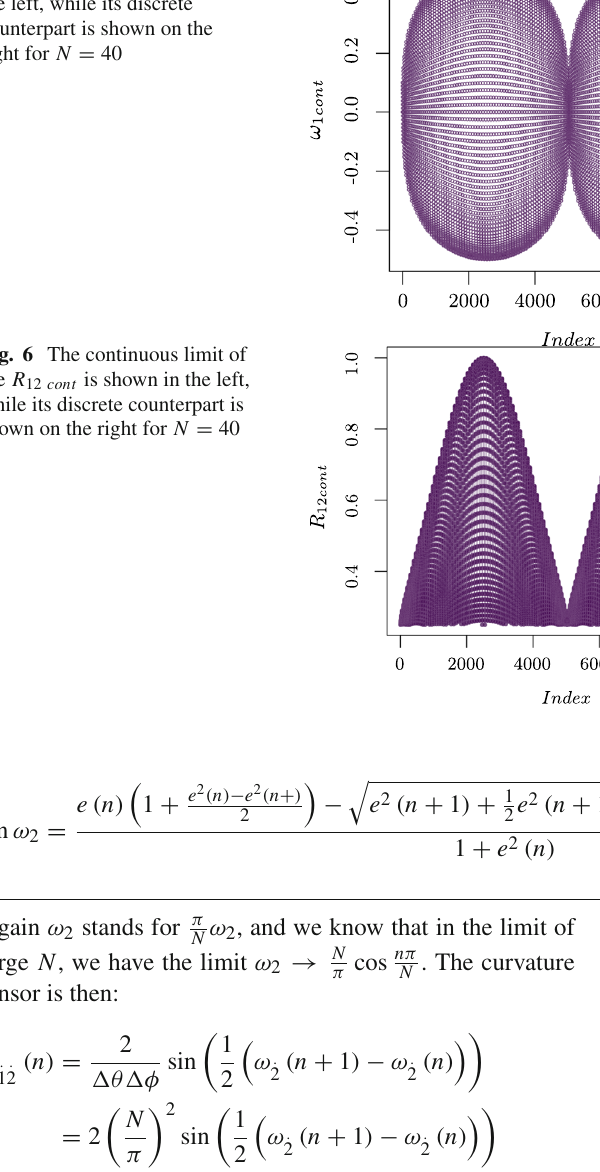
Fig. 5 The continuous limit of the curvature ω 1 cont is shown in the left, while its discrete counterpart is shown on the right for N = 40